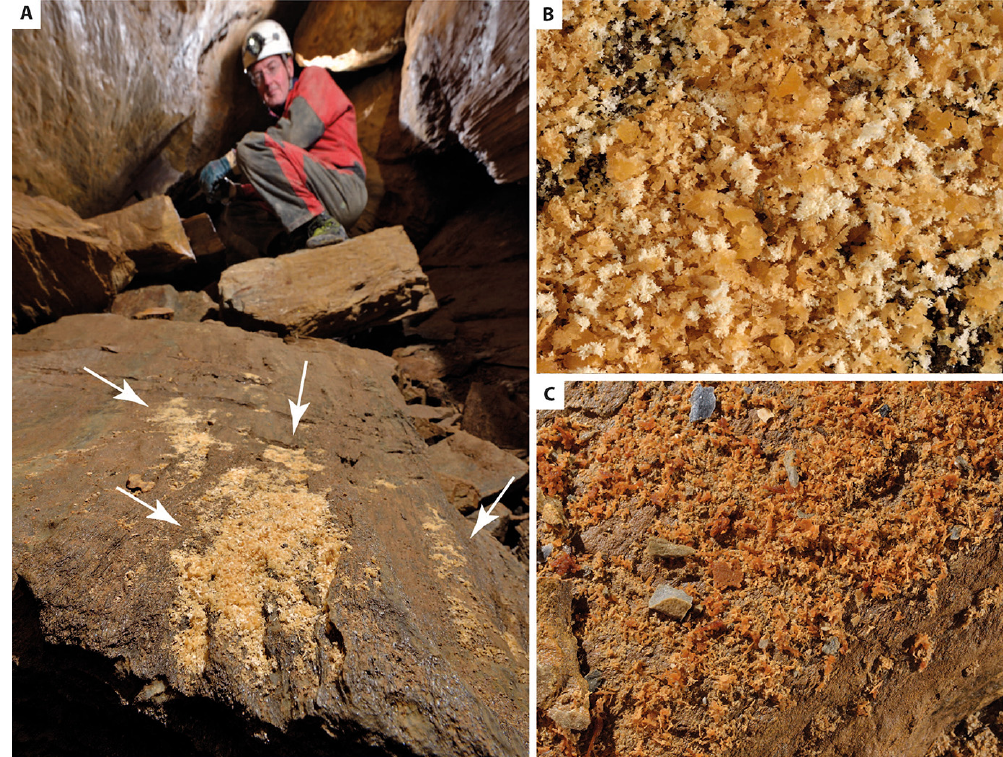
Figure 6. Cryogenic calcite deposits in MSK Cave. (a) Typical occurrence of heaps of loose crystal aggregates (arrows) in the Eiskammer chamber (sample MSK5). (b) Close-up of cryogenic deposit in the Eiskammer, consisting of brown and white crystal aggregates. Width of image 5cm. (c) Occurrence of loose brownish crystal aggregates intermixed with a few angular rock flakes on a boulder in the Kleine Eiskammer. Width of image